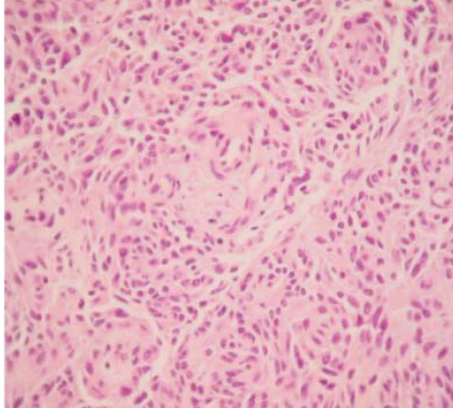
Figure 2 - Zellballen pattern (40x)